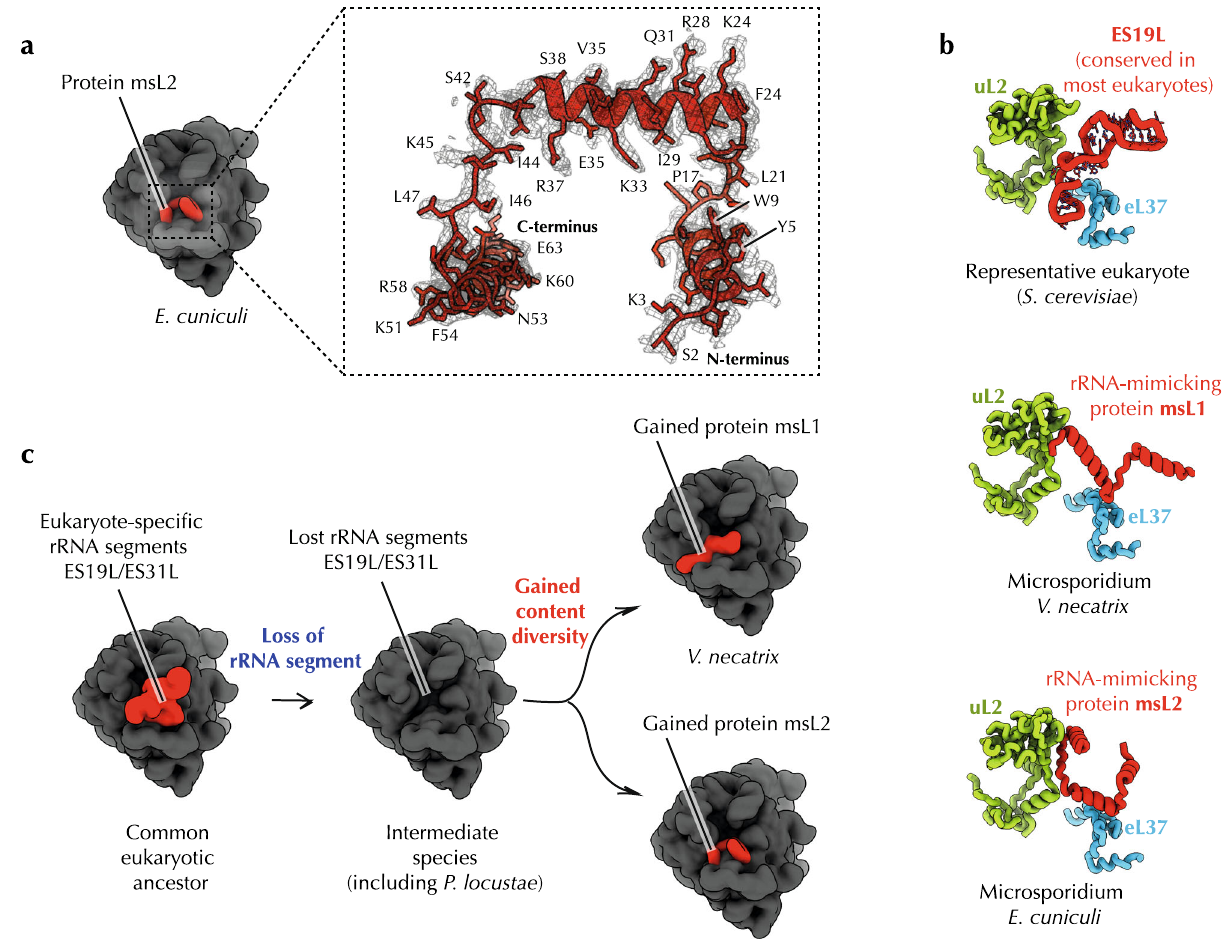
Fig. 6 The loss of rRNA expansions leads to diversi fi cation of protein content in microsporidian ribosomes. a Electron density and model of the microsporidia-speci fi c ribosomal protein msL2 found in E. cuniculi ribosomes. b Most eukaryotic ribosomes, including 80 S ribosomes of S. cerevisiae , possess the rRNA expansion ES19L, which has been lost in most microsporidian species. The previously determined structure of microsporidian ribosomes from V. necatrix showed that the loss of ES19L in these parasites was compensated by the evolution of a new ribosomal protein, msL1. In this study, we discovered that E. cuniculi ribosomes also evolved an additional RNA-mimicking ribosomal protein as an apparent compensation for the loss of ES19L. However, msL2 (currently annotated as hypothetical protein ECU06_1135) and msL1 have different structure and evolutionary origin. c This fi nding of the birth of evolutionary unrelated ribosomal proteins msL1 and msL2 illustrates that ribosomes can achieve an unprecedented level of compositional diversity, even within a small group of closely related species, if they accumulate a deleterious mutation in their rRNA. This fi nding may help shed light on the origin and evolution of mitochondrial ribosomes, which are known for their severely reduced rRNA and exceptional variability of protein composition among